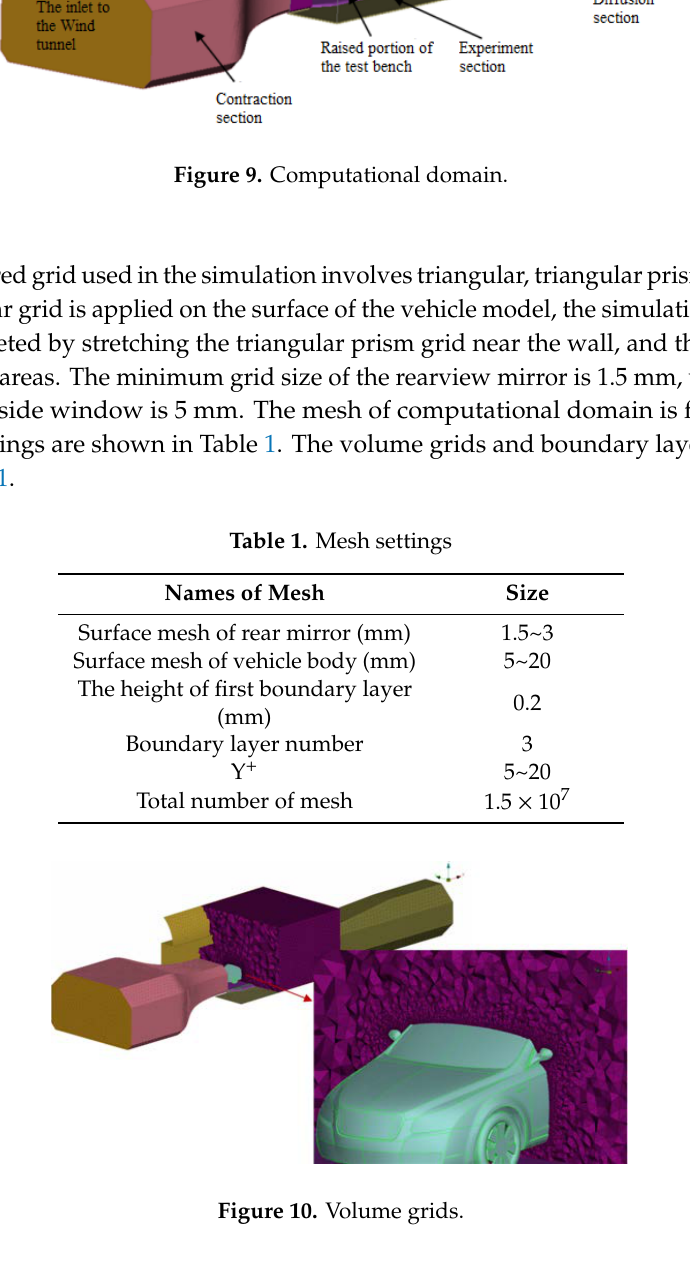
Figure 10. Volume grids.